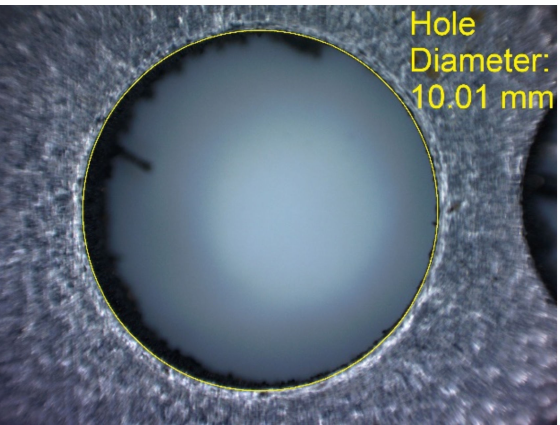
Figure 12. Measurement result for cylindrical holes and solids made in the DMLS technology: hole with a nominal diameter D d = Ø10 mm (D d1 = 10.01 mm).